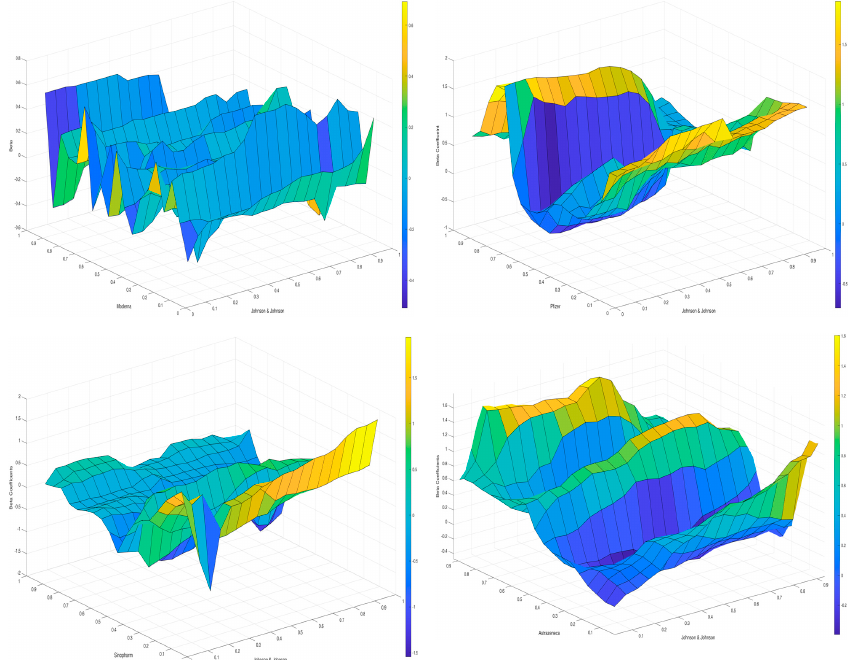
Figure 16. From Johnson & Johnson to other respective